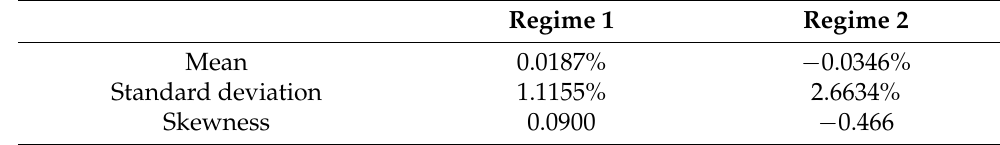
Table 5. Descriptive statistics of log-differences of implied inflation in each